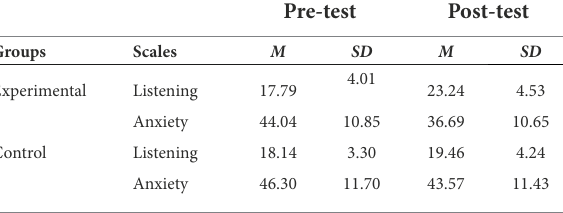
TABLE 2 Descriptive statistics for pre-and post-tests scores. Pre-test